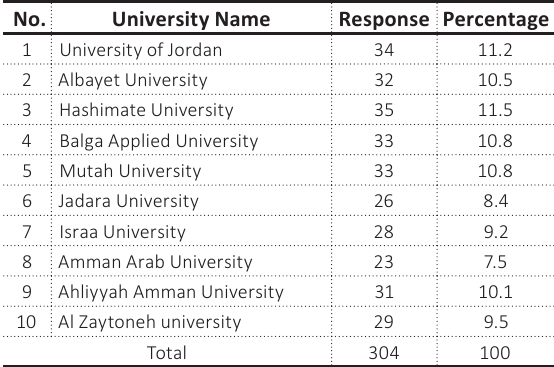
Table 1. Summary of the study sample